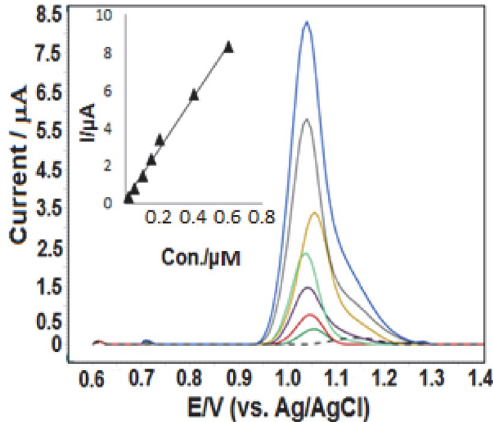
Figure 7. The stripping voltammograms for pantoprazole levels of (1) 0.024, (2) 0.06, (3) 0.12, (4) 0.19, (5) 0.24, (6) 0.48 and (7) 0.71 µM in BR buffer, pH 7.0 in the presence of 3 × 10 –4 M CTAB. Dashed lines represent background current. Inset depicts a corre- sponding calibration plot for the quantitation of pantoprazole. Oth- er operating conditions as indicated in Fig.